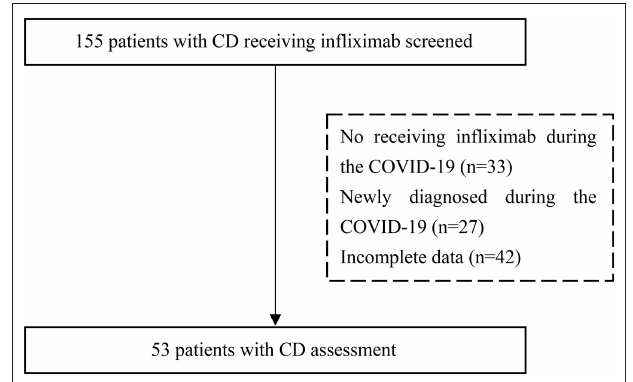
FIGURE 1 | A flow chart of the inclusion process for patients with Crohn’s disease who were treated with infliximab. CD, Crohn’s disease.